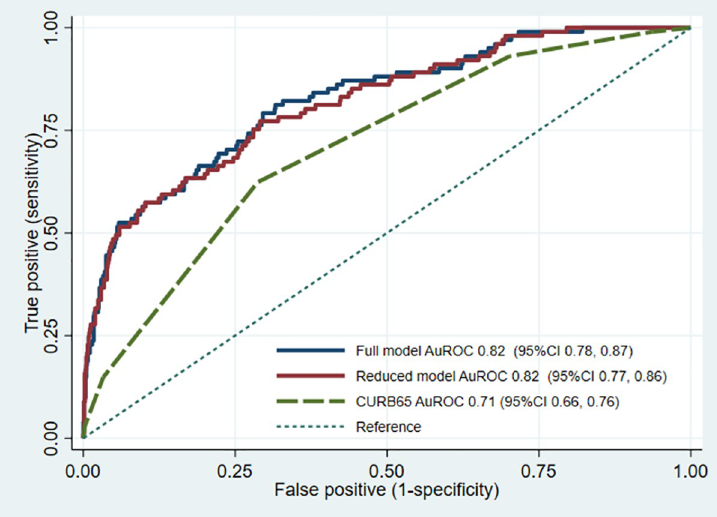
Fig 2. Receiver operating characteristic curve. Discriminative ability (area under the receiver operating characteristic curves) of the derived prediction models (full and reduced models) and the conventional CURB-65 score.